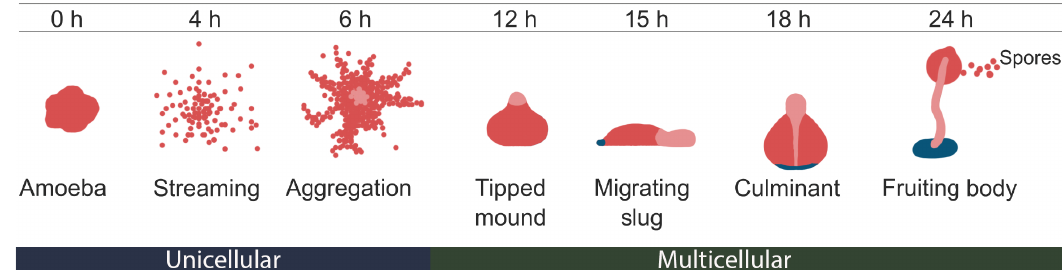
Figure 1. Life cycle of Dictyostelium discoideum . Developmental morphogenesis of D. discoideum starting from a single and vegetative amoebae (0 h). Aggregation of the single amoebae is mediated by the chemotaxis of cells to form a multicellular aggregate (6 h after starvation). During this process, multicellular aggregates stream toward a central domain or aggregation center. Aggregation results in the formation of a mound (multicellular organism, 12 h after starvation). Mound forms a tipped mound (14 h after starvation). The tip extends and forms a finger which might fall over to form a phototactic migrating slug (16 h after starvation) or begins culmination (20 h after starvation) to form a fruiting body. Finally, the fruiting body contains a sorus of spores on top of a stalk which germinate following dispersal, renewing the cycle (24 h after starvation). The figure ist modified from